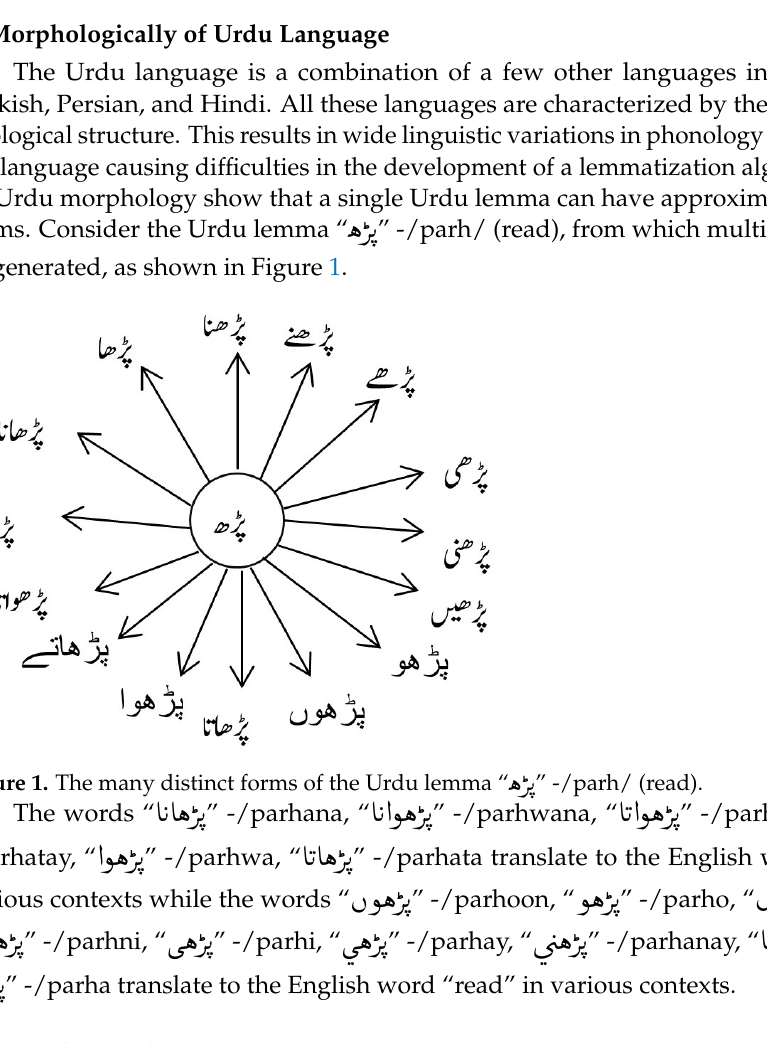
Figure 1. The many distinct forms of the Urdu lemma “